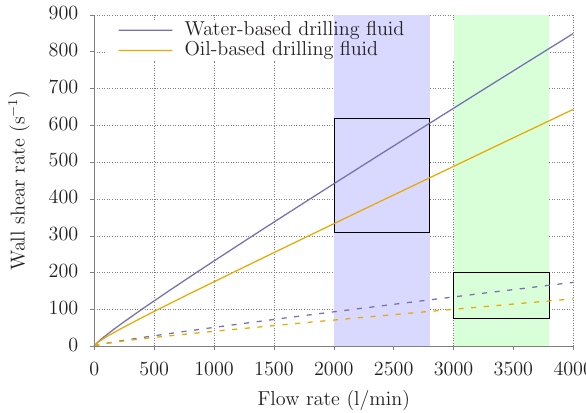
Figure 2: Shear rates at the outer wall of the drill string in a narrow annulus (solid lines - 8 1/2” outer diameter and 5 1/2” inner diam- eter) and a wide annulus (dotted lines - 12 1/4” outer diameter and 5 1/2” inner diameter) for different constant axial flow rates. The shaded and boxed regions indicate typical operational flow rates in the narrow annulus (2000 - 2800 l/min) and in the wide annulus (3000 - 3800